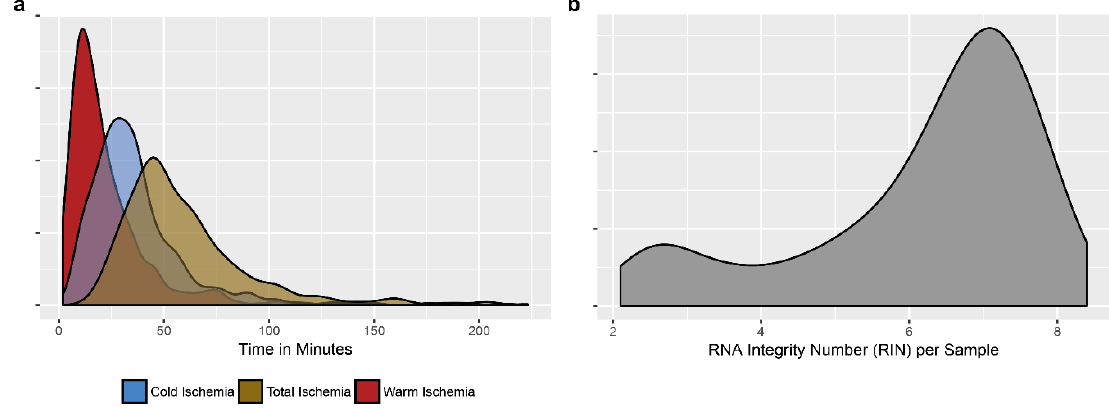
Figure 2. Qualitative data. Some criteria linked to the tissue samples which are recorded are shown; ( a ) warm ischemia time (time from clamping the first pulmonary arteria to the specimen resection) and cold ischemia time (time from getting the resected specimen in operative room until frozen